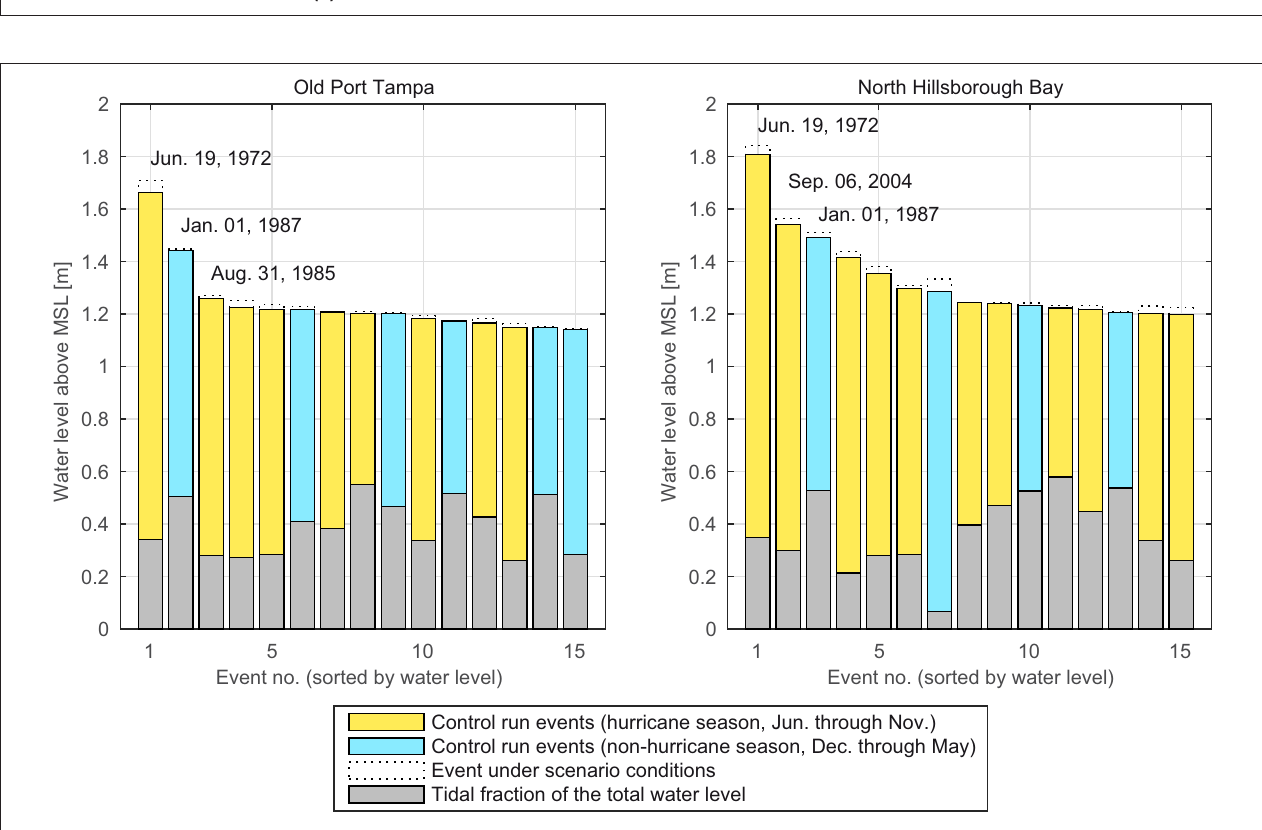
FIGURE 10 | Maximum difference in significant wave height considering all simulated events (A) and the difference expressed as ratio between scenario and control run simulation (B).